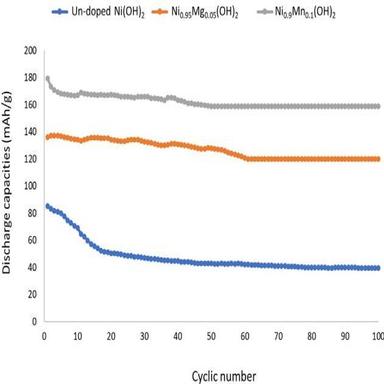
CCDG discharge capacities curves over 100 cycles for un-doped Ni (OH)2, Ni0.95Mg0.05(OH)2, and Ni0.9Mn0.1(OH)2 using the three-electrode test.